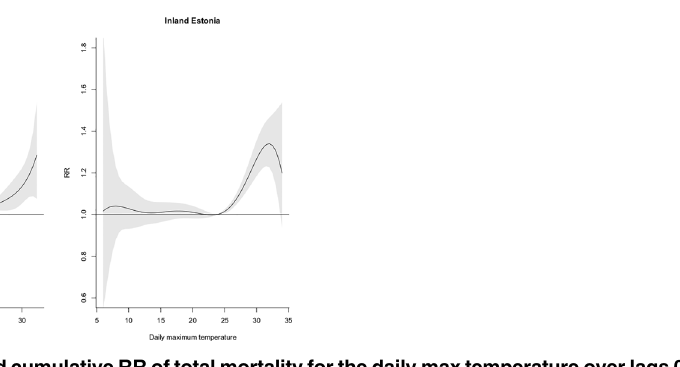
Fig 3. The estimated cumulative RR of total mortality for the daily max temperature over lags 0 – 2 for the coastal and inland region.